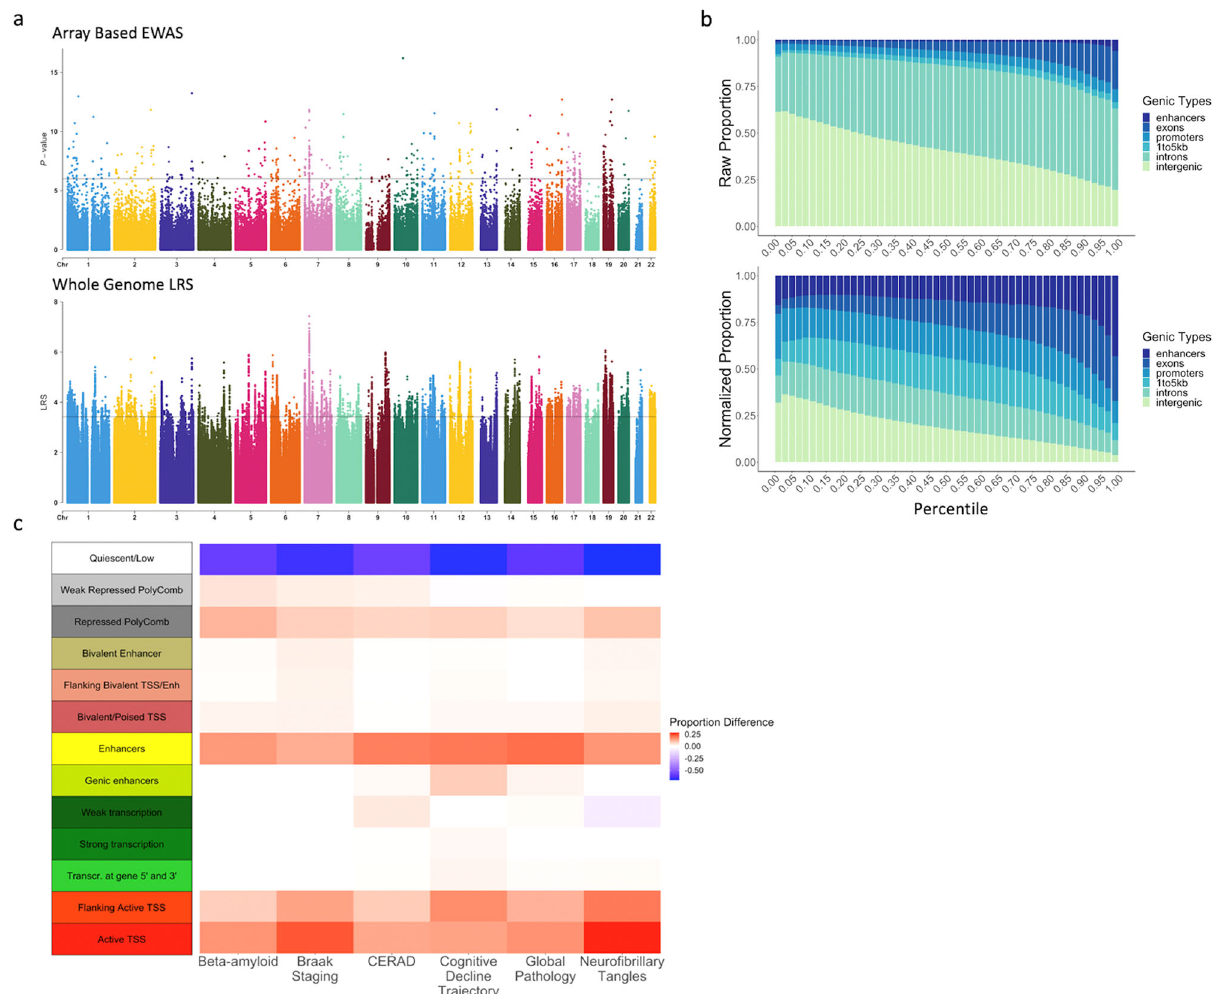
Fig. 3 Genome-wide prediction results. a Manhattan plots for neuro fi brillary tangles: the top panel is for on-450K CpGs with EWAS p -values and the bottom panel is for whole-genome CpGs with imputed LRS by EWASplus. The y -axis is the log-scale rank scores. The top-ranked CpG has the LRS of 7.42 (about empirical p -value of 3.8 × 10 − 8 ); the top 100th ranked CpG has the LRS of 5.42 (about empirical p -value of 3.8 × 10 − 6 ) and the top 10,000th ranked CpG (about empirical p -value of 3.8 × 10 − 4 ) has the LRS of 3.42. b Raw and normalized stacked-proportion histograms for different genomic annotation types. Source data are provided as a Source data fi le. c The difference of observed and expected chromatin states proportion for the top 10,000 loci across the six AD-related traits: Beta-amyloid, Braak staging, CERAD, cognitive trajectory, global pathology, and neuro fi brillary tangles. Source data are provided as a Source data fi le. The annotated chromatin states are from Roadmap Epigenetics Project and we used the core 15-state model chromatin states for the dorsolateral prefrontal cortex tissue type. To minimize ambiguity, we require only a single annotation type is assigned for each CpG site. if a CpG has multiple annotations, we only record the most “ signi fi cant ” annotation with the following order: enhancer > promoter > exon > intron > near gene (1 – 5 kb to the TSS) > intergenic. We do not list 5 ′ UTR and 3 ′ UTR since these two types are within the fi rst and last exon of each gene according to the UCSC annotation